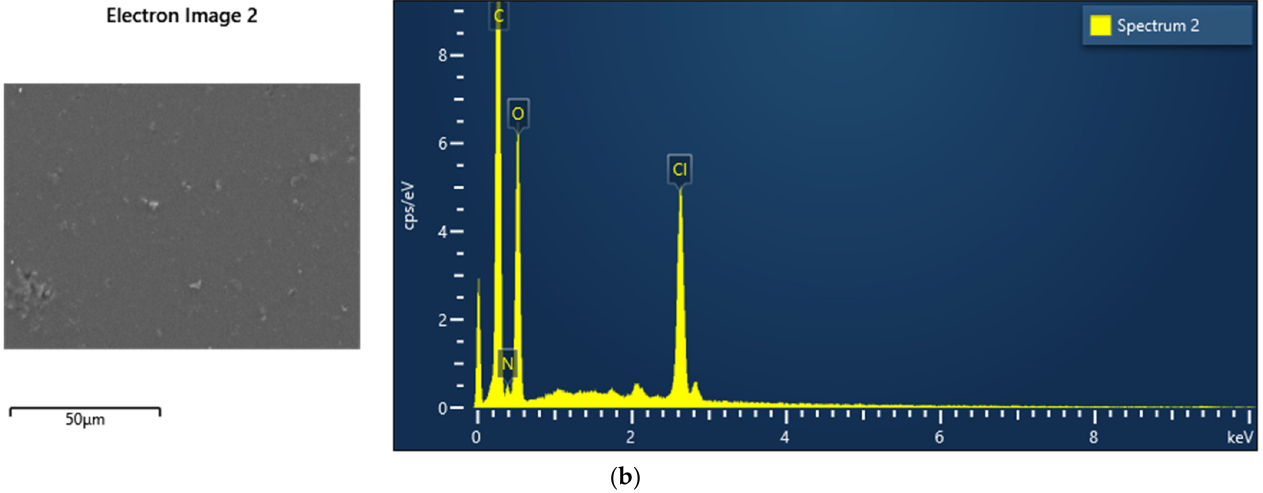
Figure 8. ( a ) SEM and ( b ) EDS of DADMAC-AAc-APTAC hydrogel. Table 1. Composition of significant elements of hydrogel.